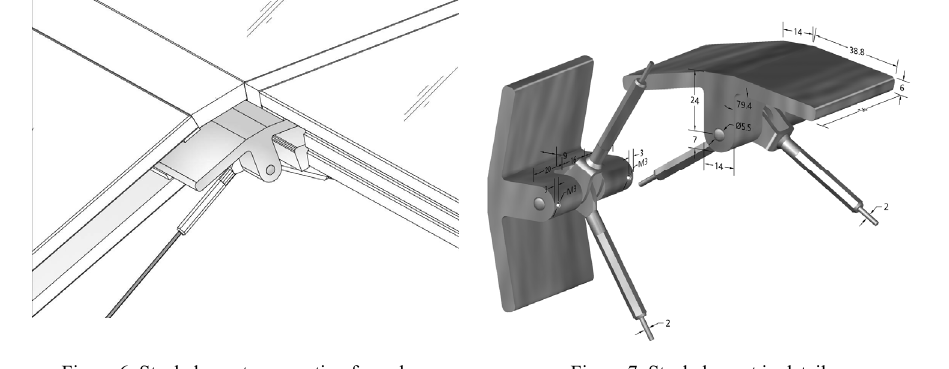
Figure 7: Steel element in detail